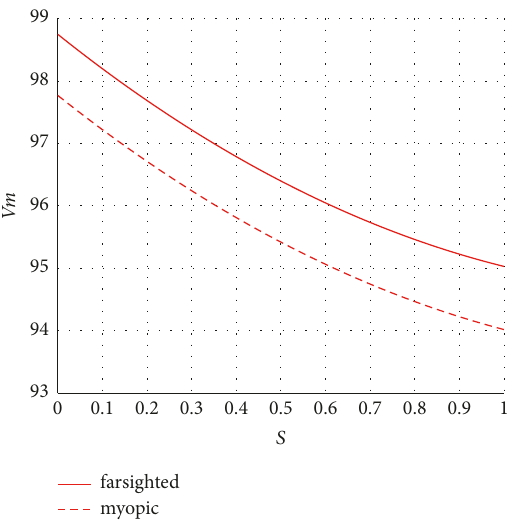
Figure 1: The profits of the manufacturer as 𝑆